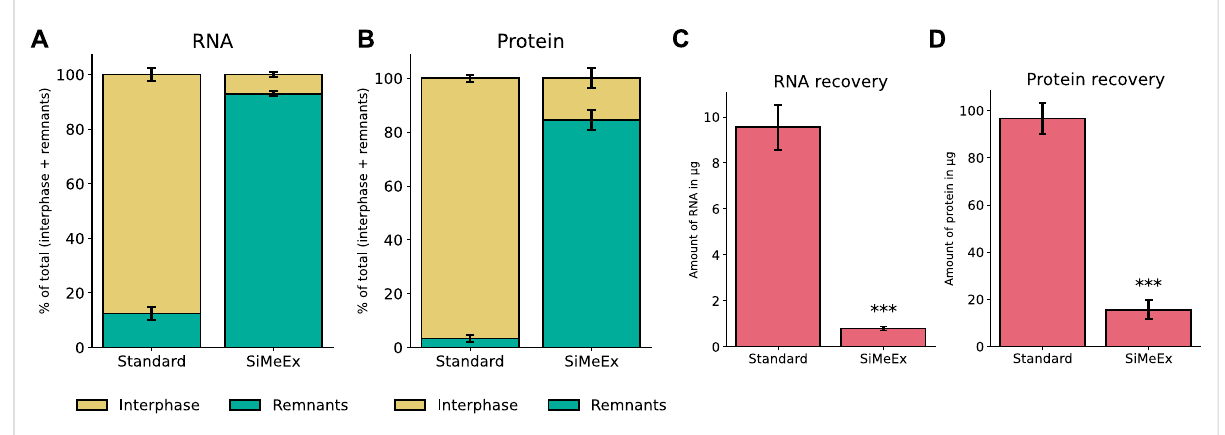
FIGURE 3 Co-extraction of nucleic acids and proteins. (A,B) . Distribution of recovered RNA (A) and protein (B) between interphase of extraction fl uids (Interphase) and cellular remnants after extraction (Remnants), using the ‘ standard ’ and SiMeEx methods, and the data present the percentage distribution of Interphase and Remnants. (C,D) . Yield of RNA (C) and protein (D) recovered from interphase of extraction fl uids, using ‘ standard ’ or SiMeEx methods. All data are presented as mean ± SEM calculated from three independent experiments with n = 3 technical replicates. Signi fi cances were calculated by unpaired student ’ s t -test with p < 0.001: